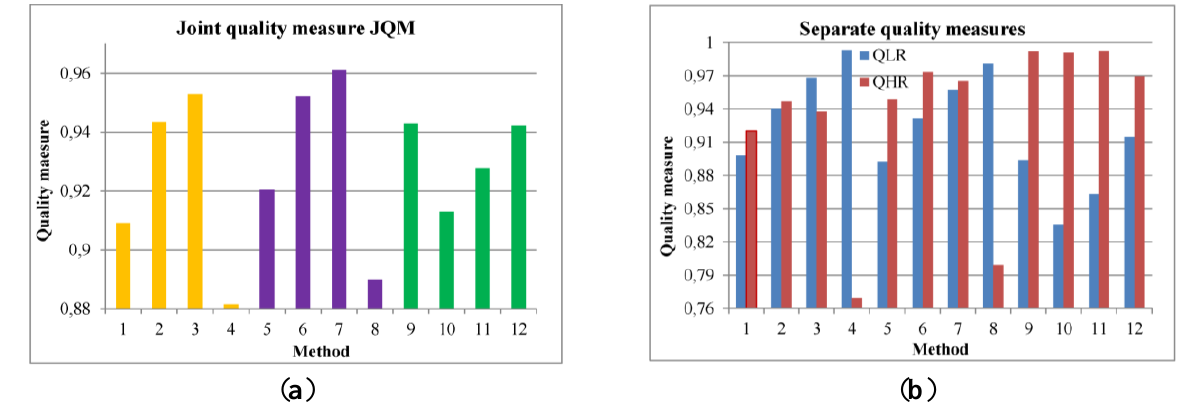
Figure 9. JQM and separate measures for 6 methods and their different parameter settings for IKONOS data. ( a ) JQM, ( b ) QLR and QHR.